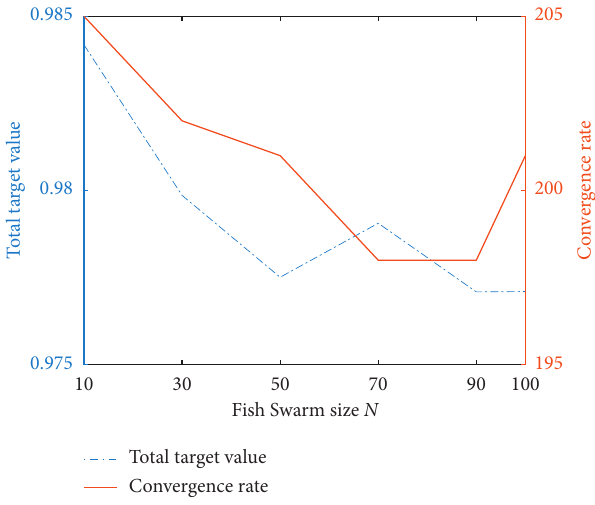
Figure 2: Adjustment of the parameter N .